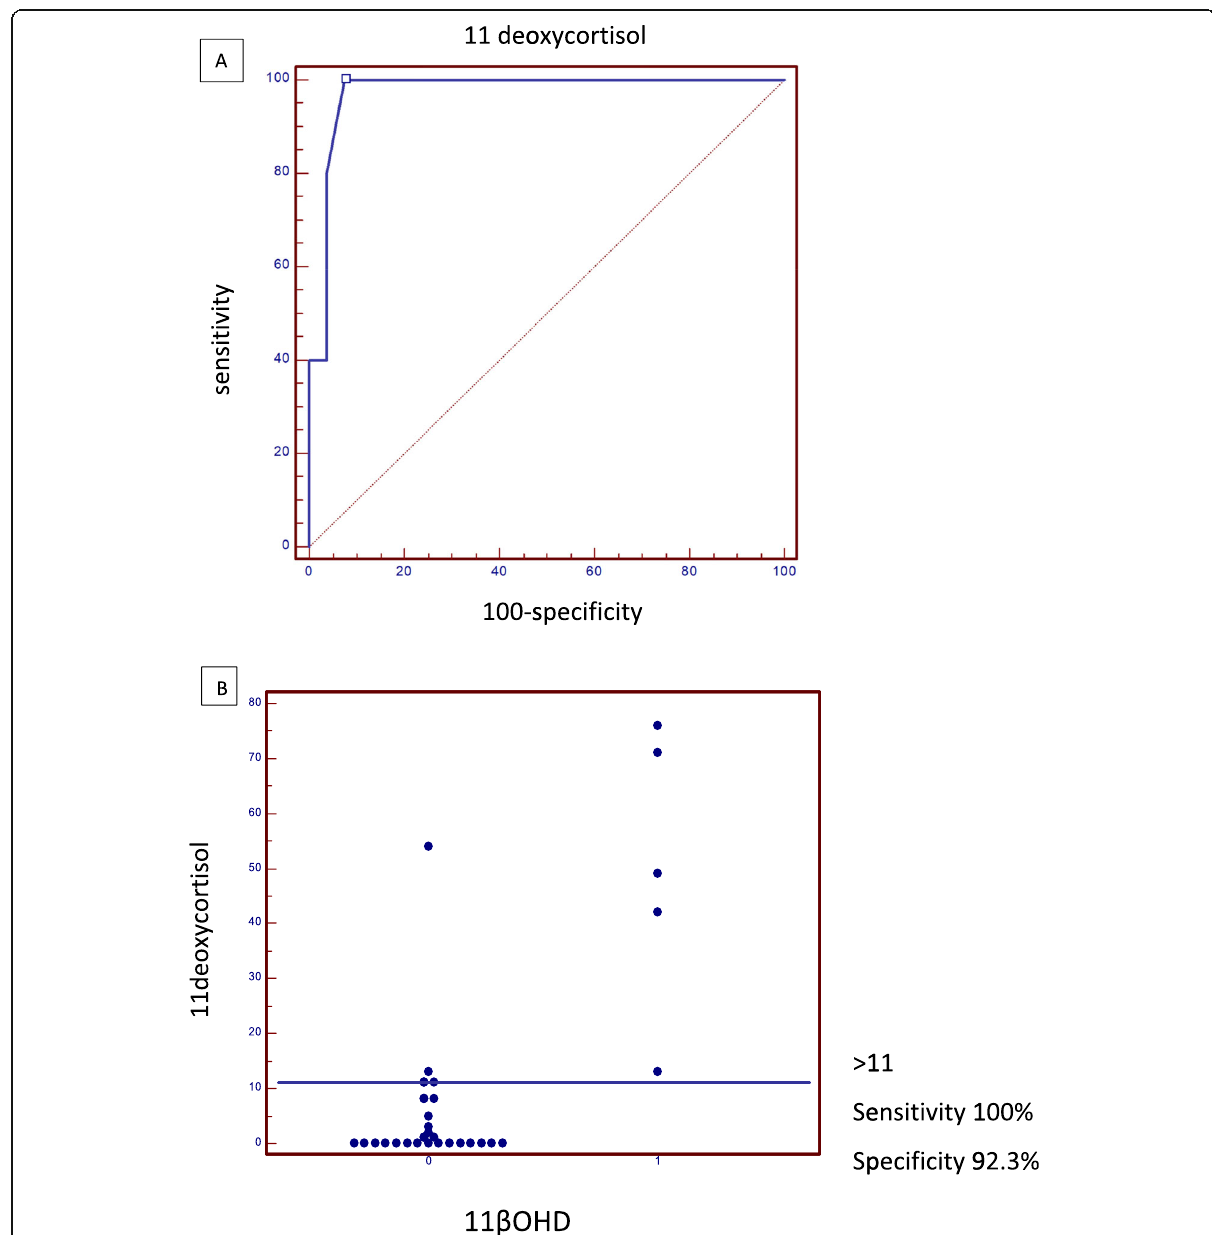
Fig. 2 a ROC curve of 11 deoxycortisol measured by LC MS/MS in diagnosis of CAH due to 11bOHD. b A dot plot chart shows that at cutoff ≥ 11 ng/ml for 11 deoxycortisol measured by LC-MS/MS, sensitivity was 100% and specificity 92.3% for